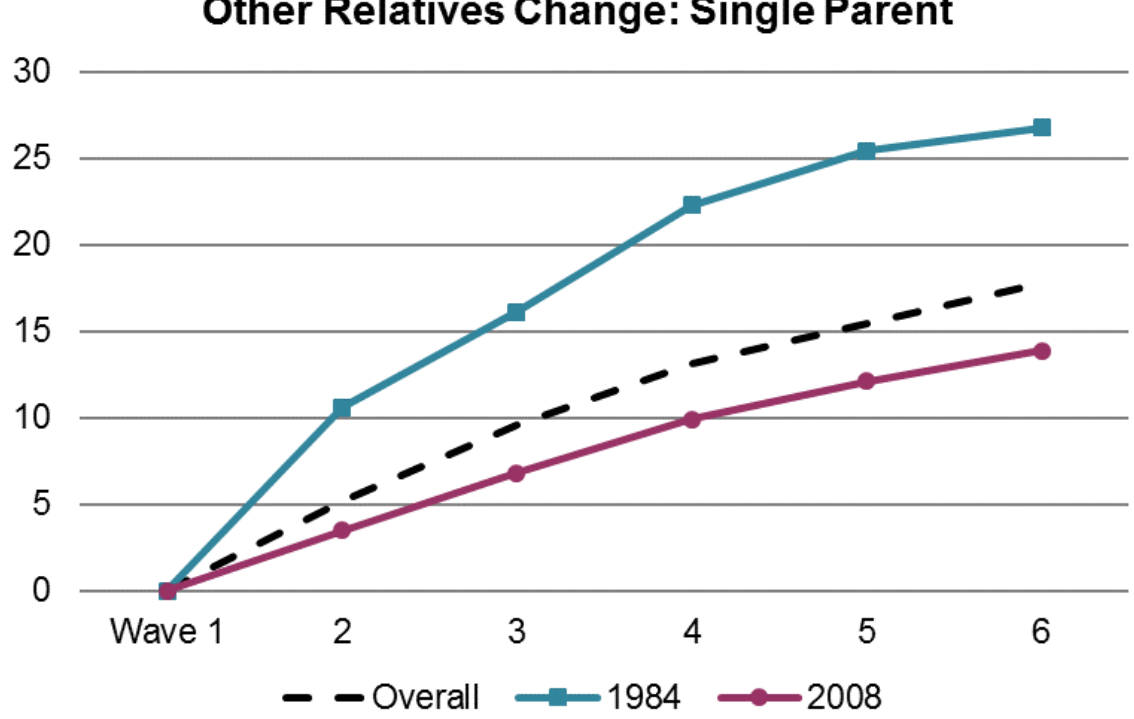
Figure 6: Weighted cumulative percent of children (by panel) living with single parents and exposed to other relatives leaving and joining